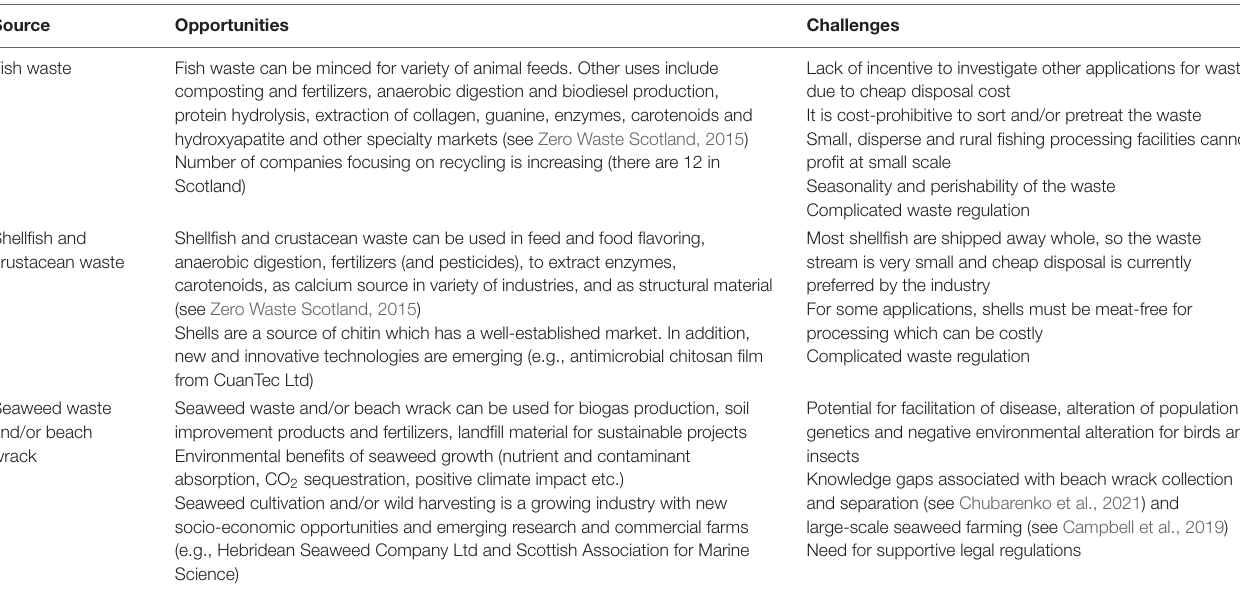
TABLE 6 | Summary of marine waste utilization in